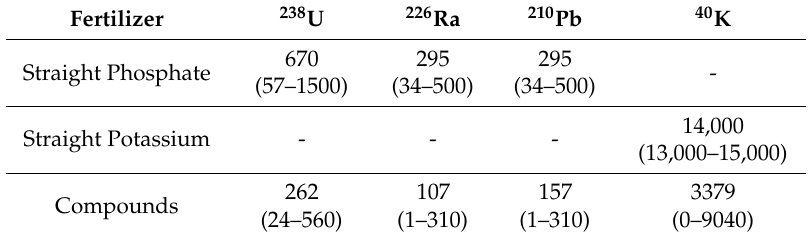
Table 1. Average values of activity concentration (Bq / kg) of natural radionuclides in Italian straight and compound fertilizers samples [8,15]. The minimum and maximum values are shown in brackets.